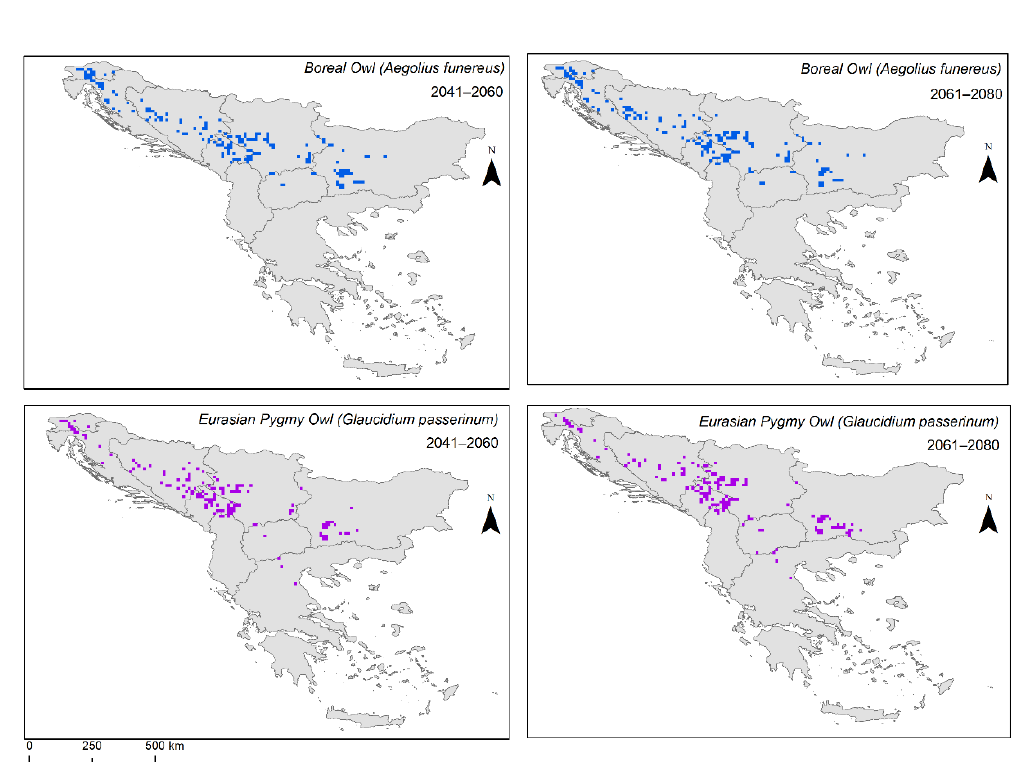
Figure 3. Predicted highly suitable habitat of Eurasian Pygmy Owl ( Glaucidium passerinum ) under projected future climate scenarios (SSP 126, 245, 370, 585) in two different periods: 2041–2060 and 2061–2080. Colour coding: beige = unsuitable habitat; light yellow = poorly suitable habitat; dark yellow = moderately suitable habitat; red = highly suitable habitat).